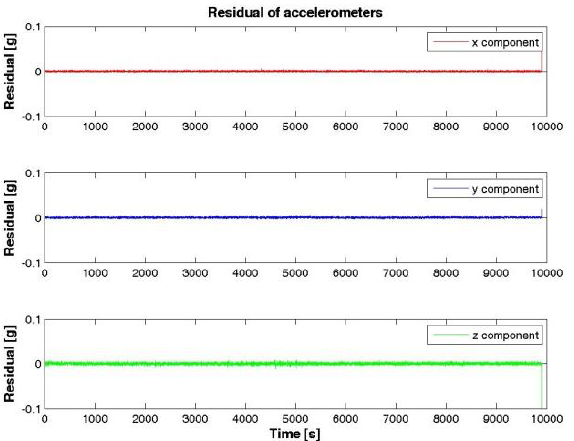
Figure 12 - Acceleration residuals for IPhone4